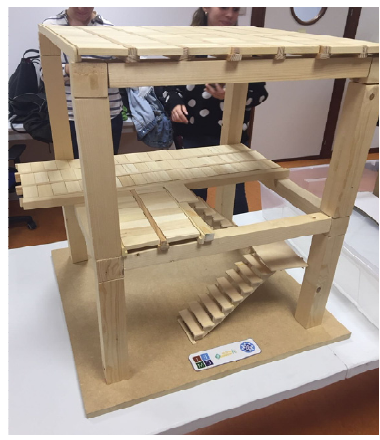
Figure 7. Wooden model of the structure of a reinforced concrete (RC) building.